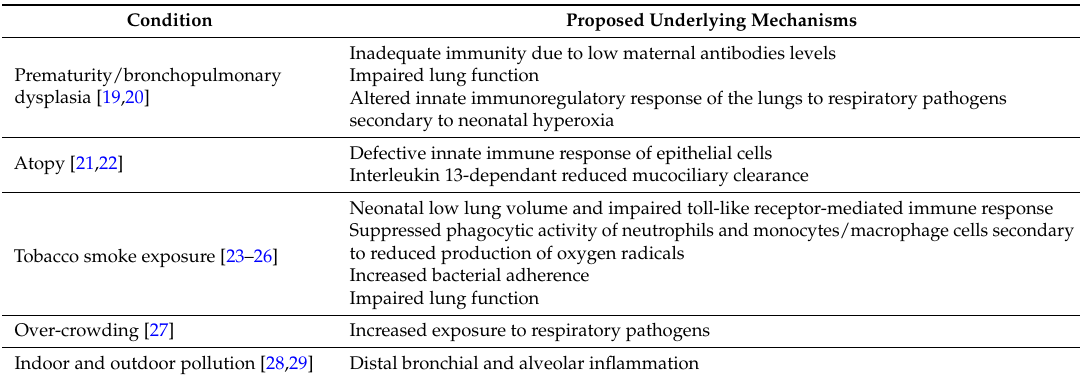
Table 1. Risk factors for recurrent pneumonia in